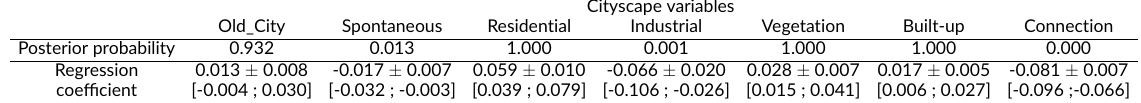
Table 3 – Result of the Bayesian CAR